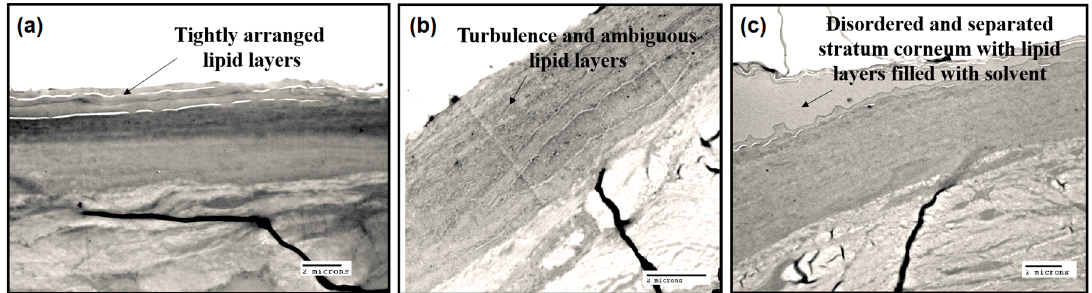
Figure 10. Transmission electron microscope (TEM) views of hairless rat skins with 10% osthole and different concentrations of borneol treated at 35 °C for 24 h: ( a ) 0%; ( b ) 0.54%; and ( c ) 1.02%. Bar = 2 μ m.